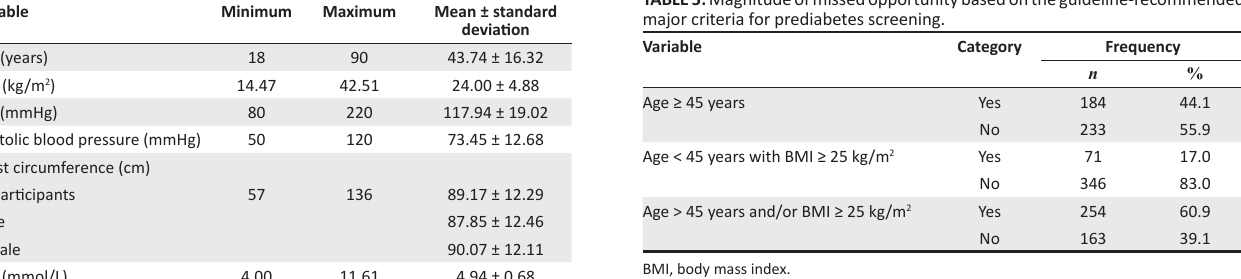
TABLE 2: Summary statistics of the continuous variables.